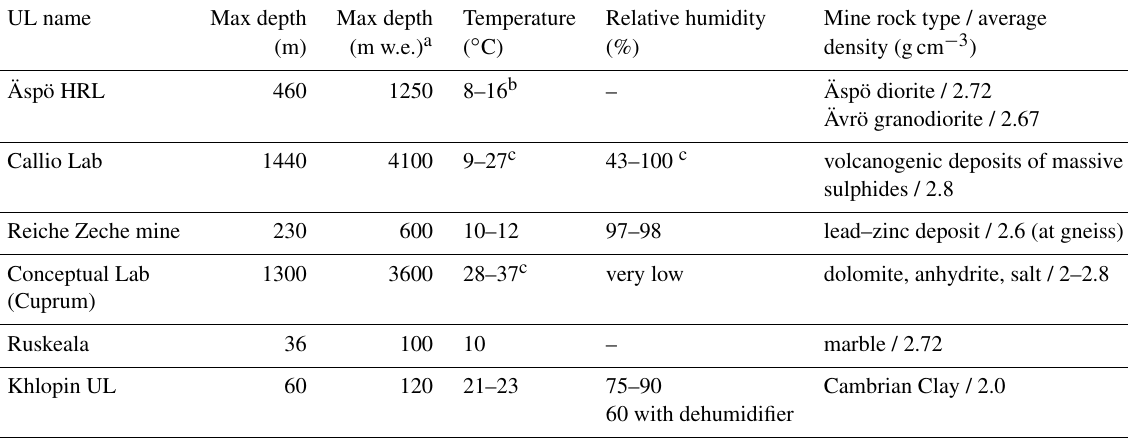
Table 2. Characteristics of BSUIN and EUL ULs environmental